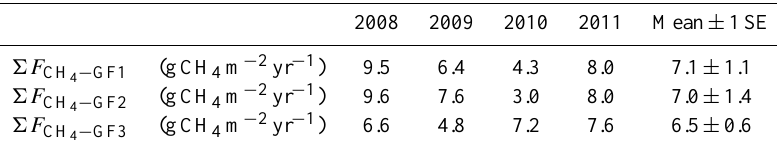
Table 3. Cumulative annual CH 4 emissions for all days when daily mean air temperature ≥ 0 ◦ C gap-filled by (1) using linear interpolation ) , (2) using linear interpolation to fill 30min gaps between measured F CH to gap-fill missing days between measured F CH ( 6F CH 4 4 − GF1 ) , and (3) modelling the missing 30min F CH ( 6F CH values using the T soil5 linear regression relationship with F CH 4 − GF2 4 der + growing seasons) up to 12 ◦ C and above this temperature, the daily flux was assumed constant at 47nmolCH 4 m − 2 s − 1 ( 6F CH Mean annual CH 4 emissions ± 1SE for the study years 2008–2011 also